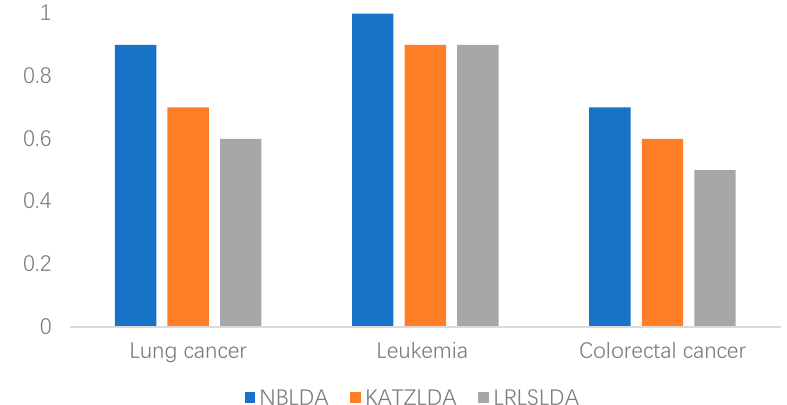
Figure 3. The accuracy of the top 10 related lncRNAs for lung cancer, leukemia, and colorectal cancer predicted by NBLDA, KATZLDA, and LRLSLDA, respectively.